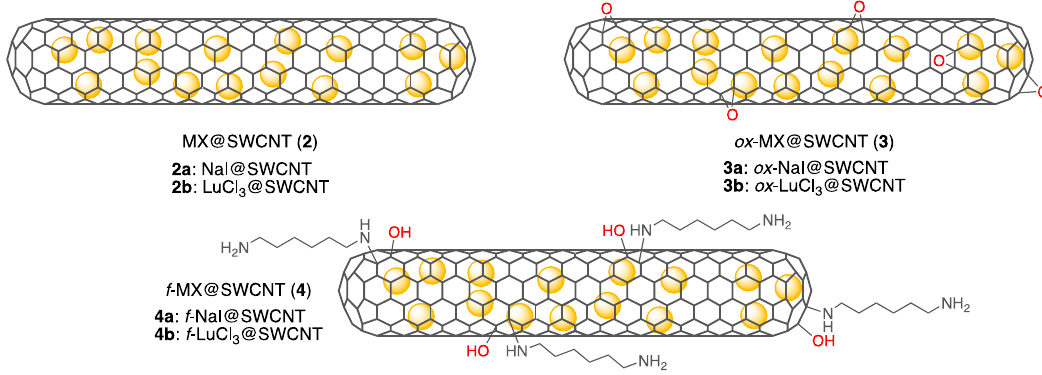
Figure 2. Schematic representation of MX@SWCNTs 2 , ox -MX@SWCNTs 3 and f -MX@SWCNTs 4 .